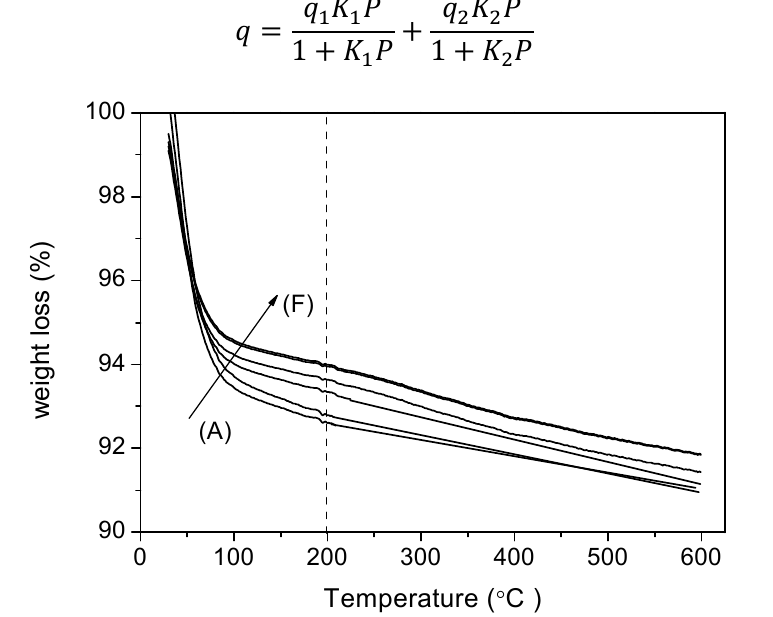
Figure 6. Thermogravimetry (TGA) thermograms of (A) RT; (B) RT-F; (C) HT; (D) HT-F; (E) TiPB and (F)